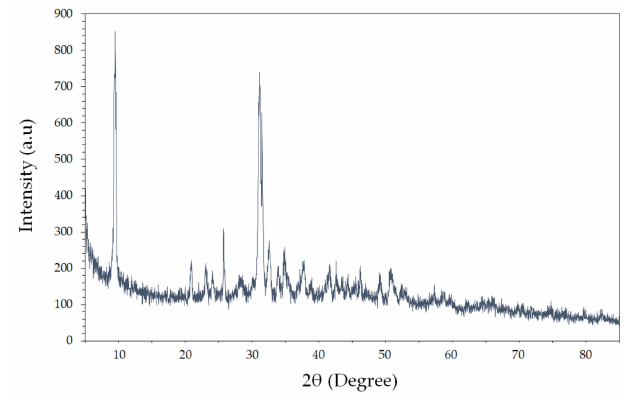
Figure 2. XRD patterns of the Ag/rGO/CS